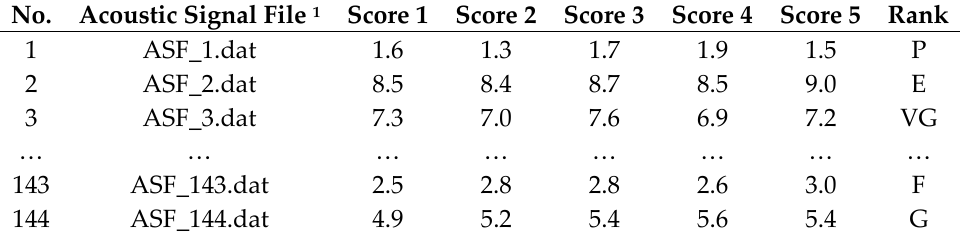
Table 1. Acoustic library of Chinese lute.